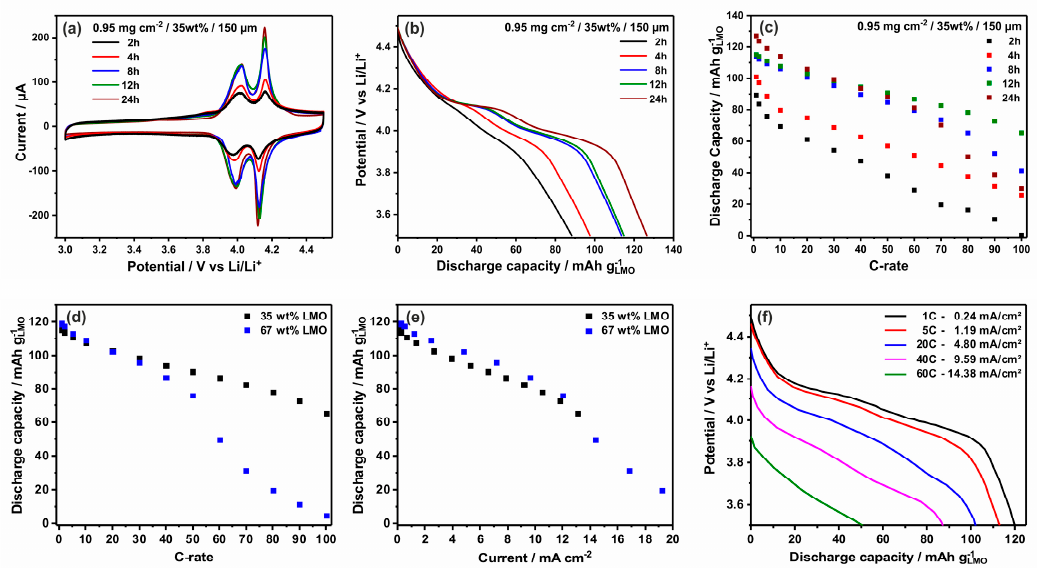
Figure 4. Electrochemical characterization of LMO–VACNT nanoarrays prepared at 2 h, 4 h, 8 h, 12 h, and 24 h/225 ◦ C. ( a ) Cyclic voltammograms at a sweep rate of 0.1 mV s − 1 . ( b ) Voltage profiles at 1 C. ( c ) Discharge capacities at galvanostatic rate test up to 100 C. ( d ) Rate performance test of a 35 wt % and a 67 wt % LMO nanoarray. ( e ) Rate performances plotted against the applied areal current density. ( f ) Voltage profile of a 67 wt % LMO nanoarray at increasing C-rates.